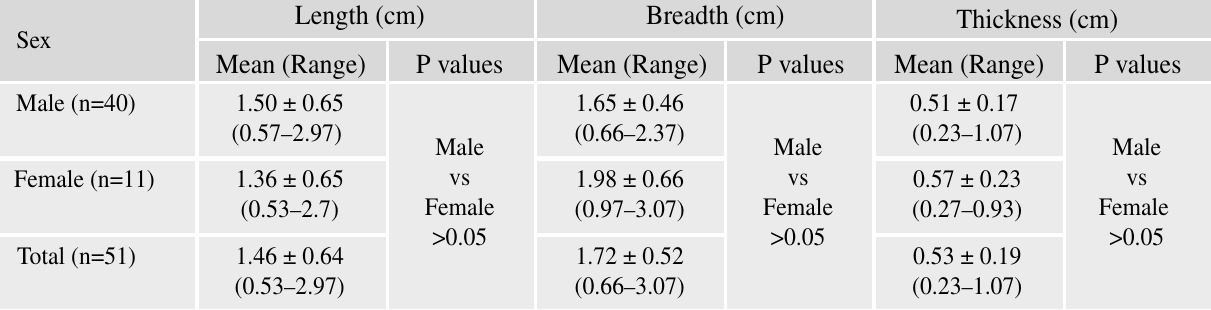
The post-Hoc option of analysis of variance (ANOVA) test was done to compare each group from other group for each variable. The difference was considered to be significant statistically at 5% level (i.e. p<0.05). Table III: Length, breadth and thickness of isthmus of the thyroid gland in male and